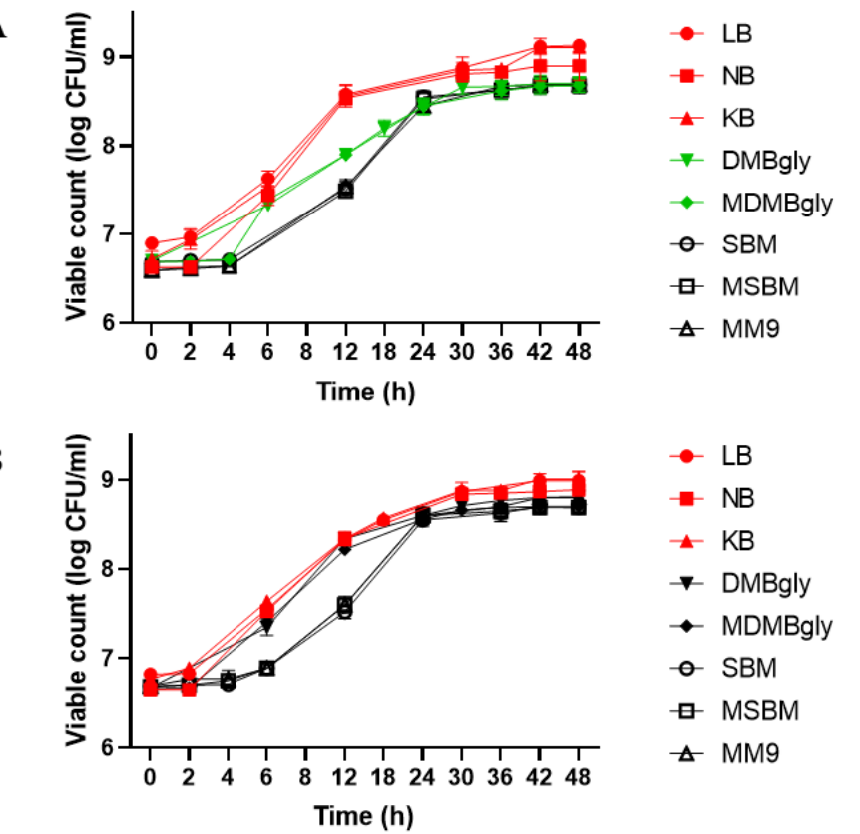
Figure 3. Viable count of ( A ). J. lividum and ( B ). J. agaricidamnosum in various media.